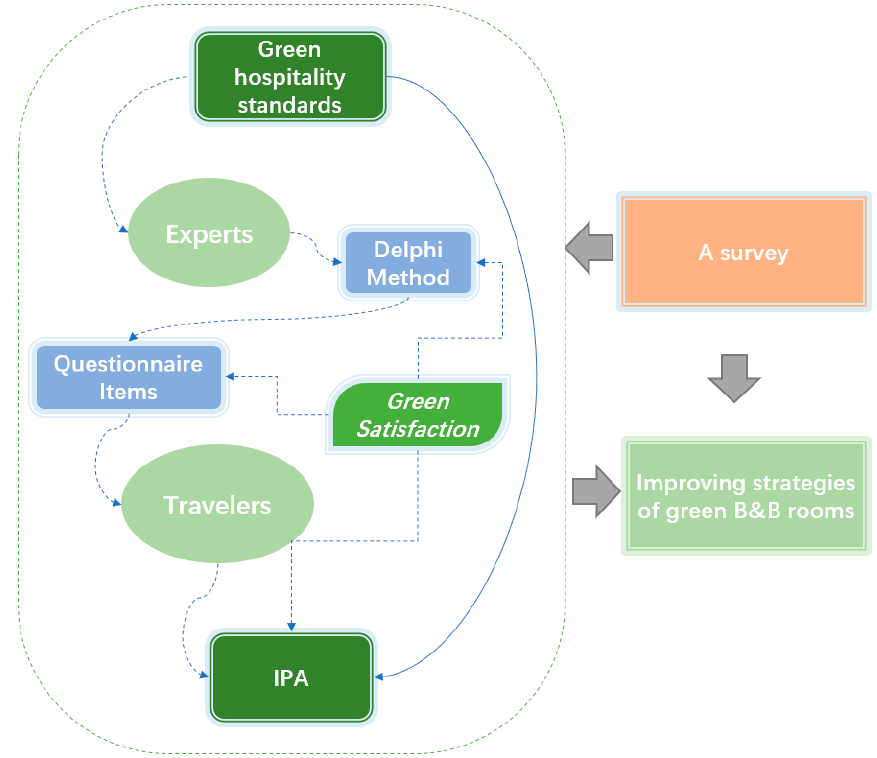
Figure 1. The logical model.